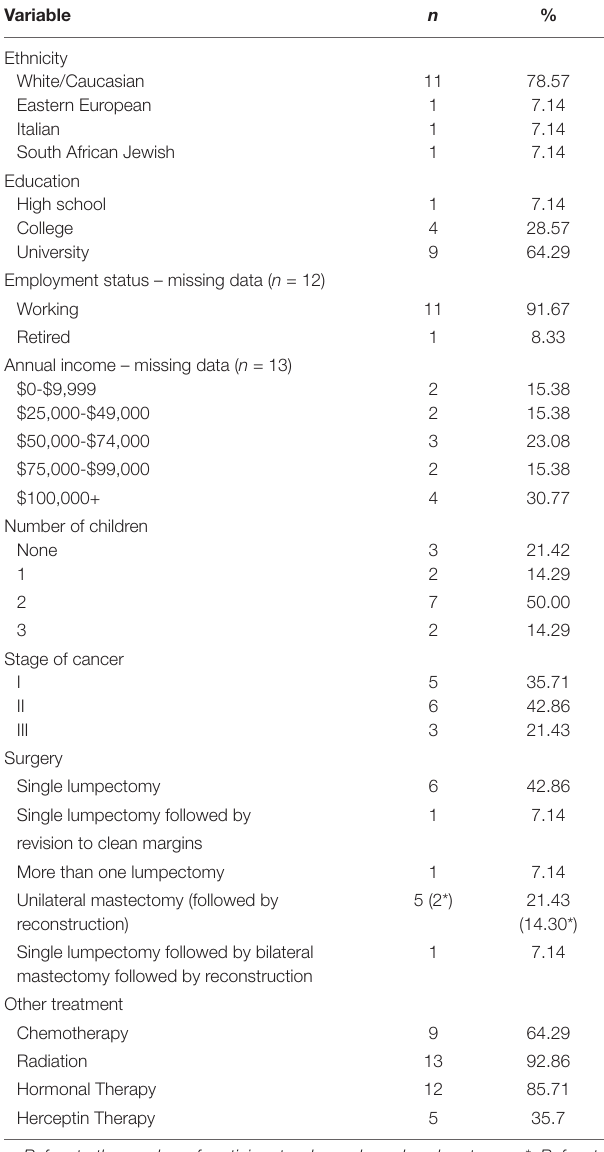
TABLE 2 | Demographic characteristics ( N = 14). TABLE 3 | Qualitative themes and sub-themes regarding preliminary effectiveness